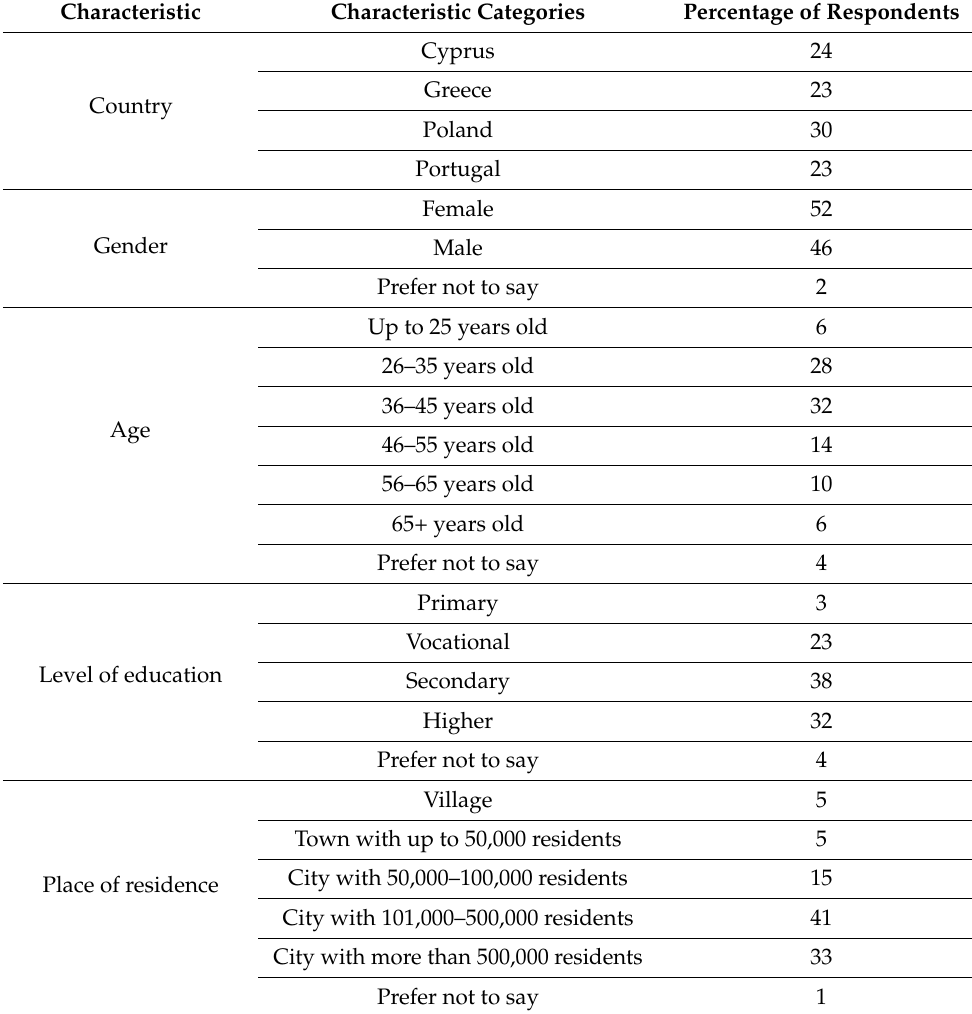
Table 1. A research sample—structure according to selected characteristics ( N = 131). Characteristic Characteristic